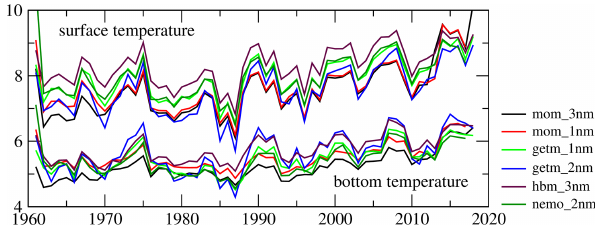
Figure 9. Annual mean surface and bottom water temperatures av- eraged over the entire Baltic Sea.